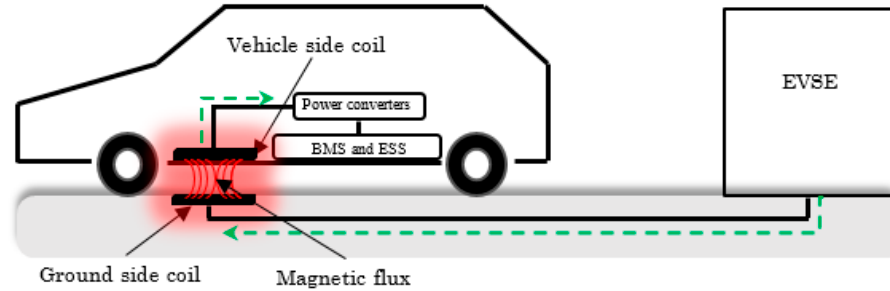
Figure 1. Simplified concept of a WPT charger.